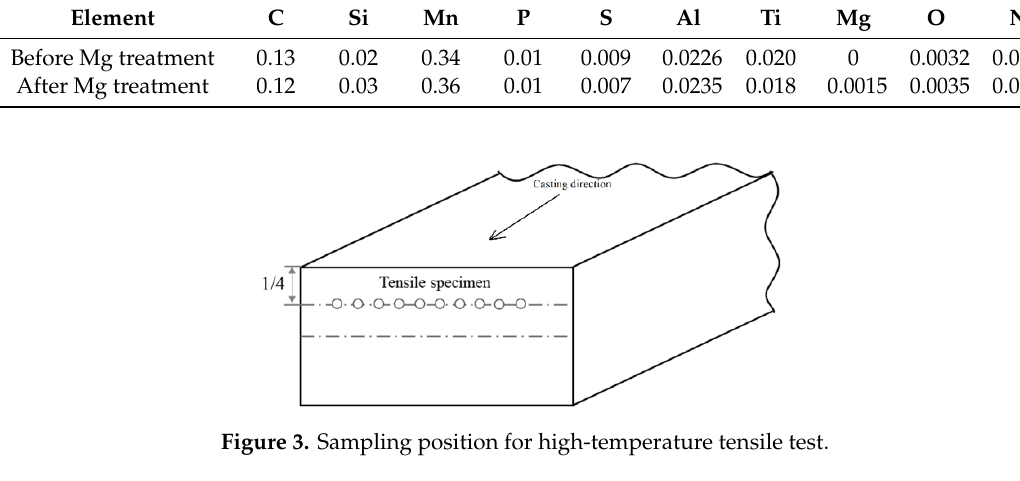
Table 1. Composition of the peritectic steel (wt%).